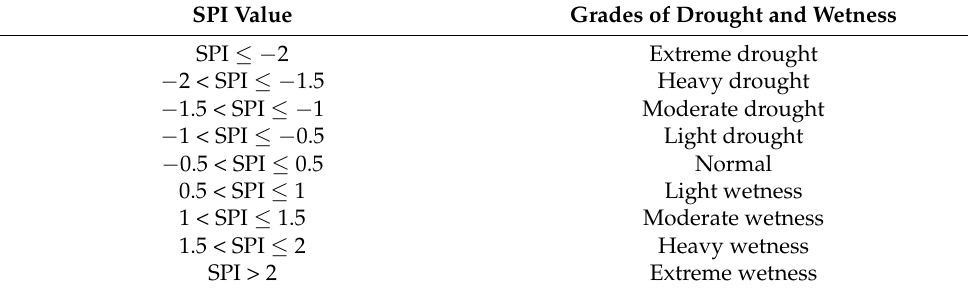
Table 1. Standardized Precipitation Index (SPI) drought and wetness degrees